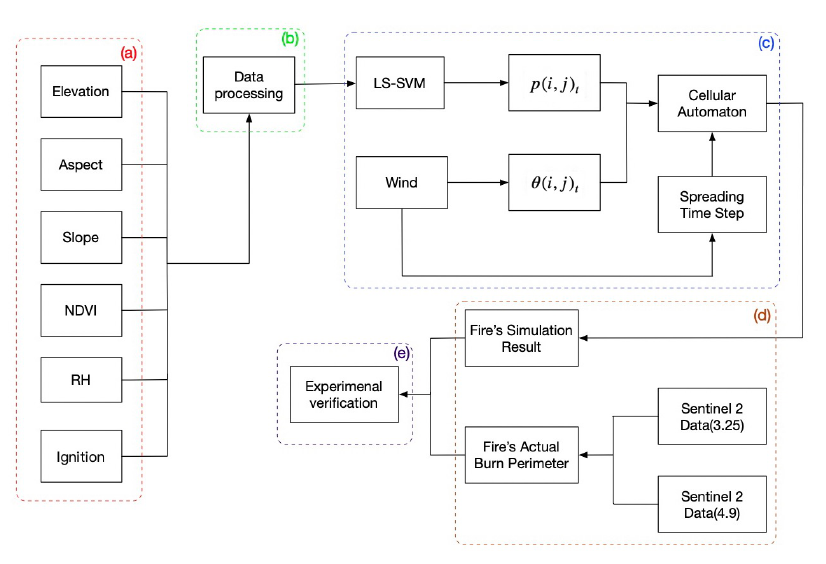
Figure 1. The flowchart of the proposed method: ( a ) data collection; ( b ) data pre-processing; ( c ) mod- eling; ( d ) acquisition of simulated and actual combustion data; and ( e ) model validation.